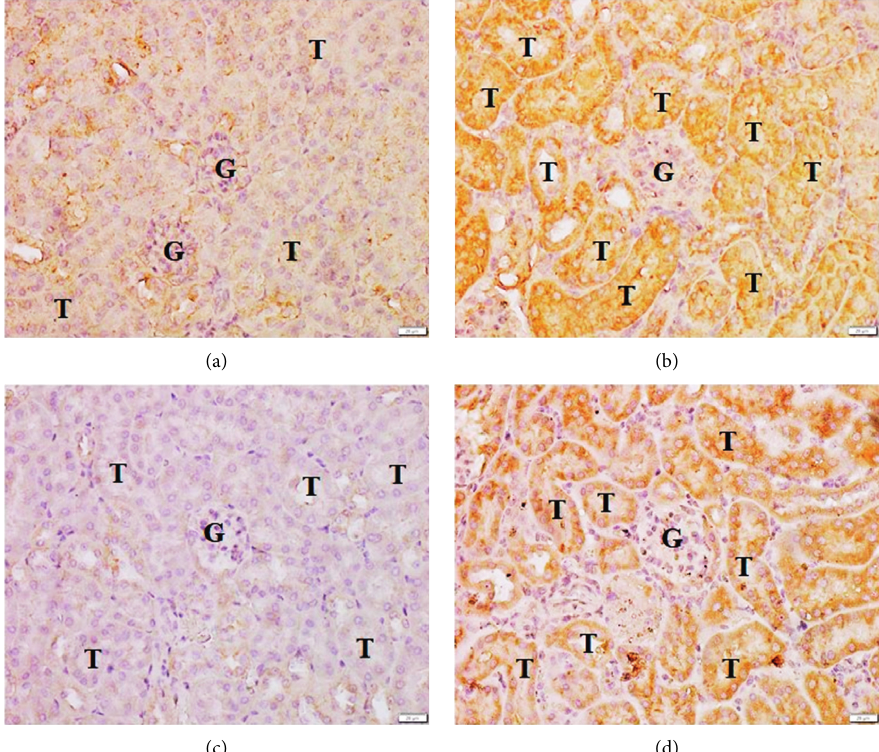
Figure 3: Immunohistochemistry staining for 4-HNE and HO-1 in kidney sections from the control and P. berghei -infected groups. The kidney sections of the control group showed very weak staining for 4-HNE (a) and HO-1 (c). The kidney sections of P. berghei -infected mice showed strong positive staining for 4-HNE (b) and HO-1 (d). 200x magnification, bar � 20 μ m. G, glomerulus; T, renal